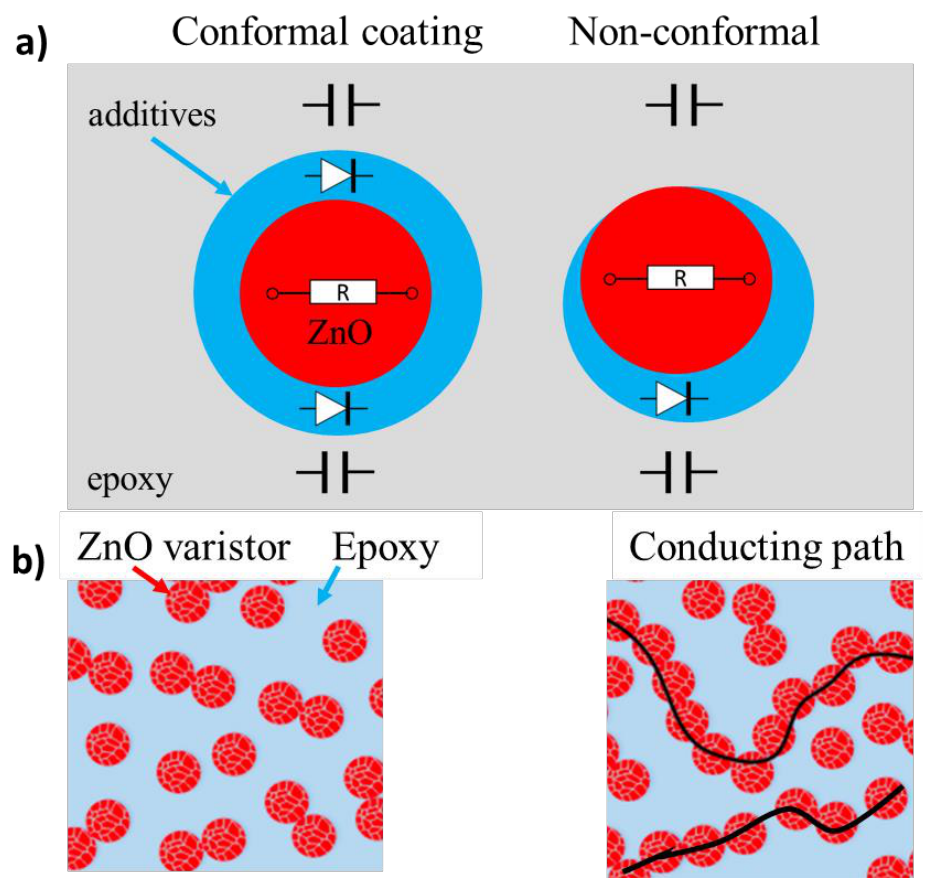
Figure 8 . ( a ) The schematic model of ZnO varistor particles in the epoxy matrix. ( b ) The schematic distribution of ZnO varistor particles with isolated dispersion at lower loading ( left ) and interconnected configuration at higher loading ( right ).